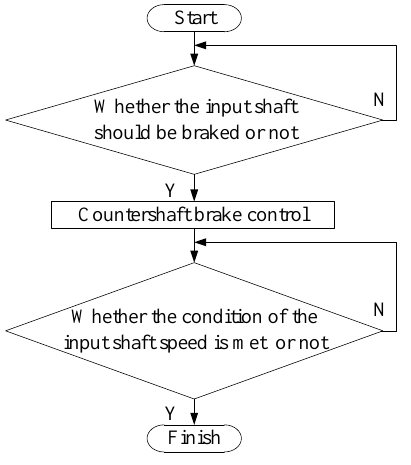
Figure 5. Logical diagram of TB control flow.